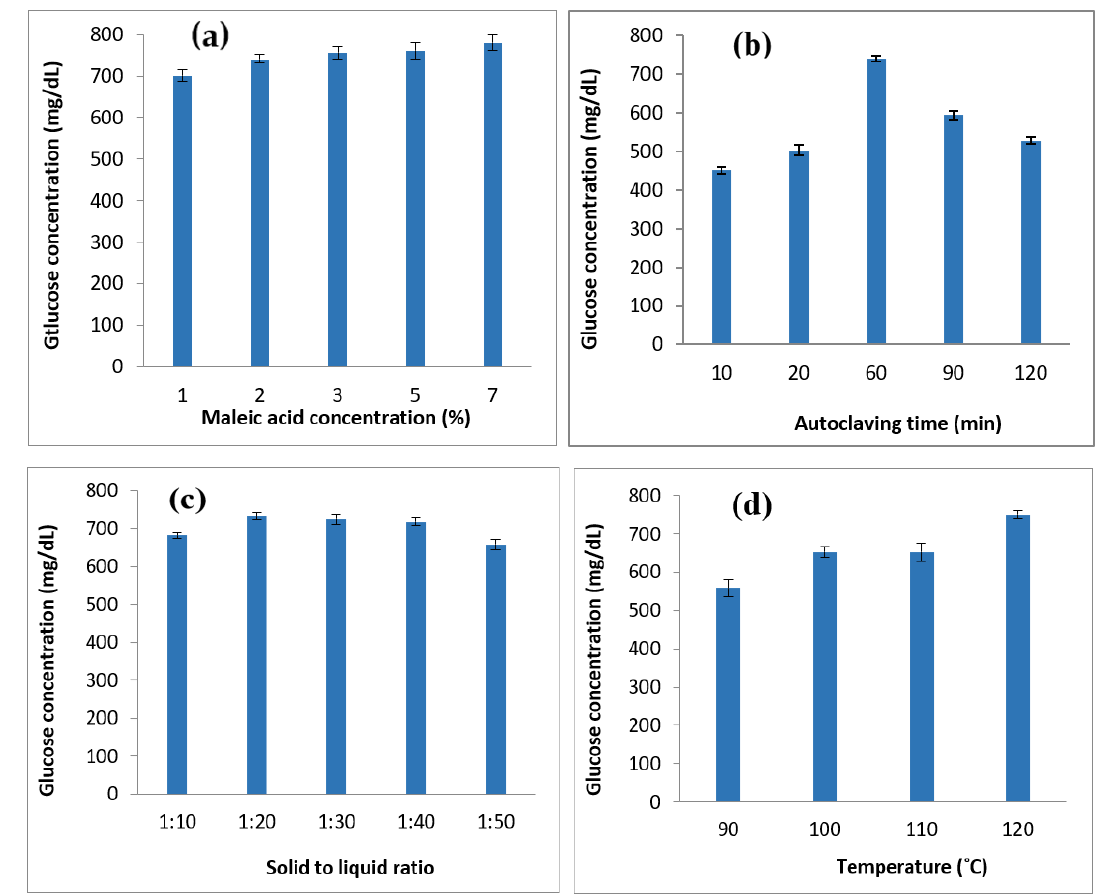
Figure 8. Glucose concentration release using different pretreatment processes. ( a ) Effect of maleic acid concentration; ( b ) effect of autoclaving time; ( c ) effect of solid-to-liquid ratio; ( d ) effect of temperature (2% maleic acid, 120 °C for 60 min, 1:20 solid-to-liquid ratio).